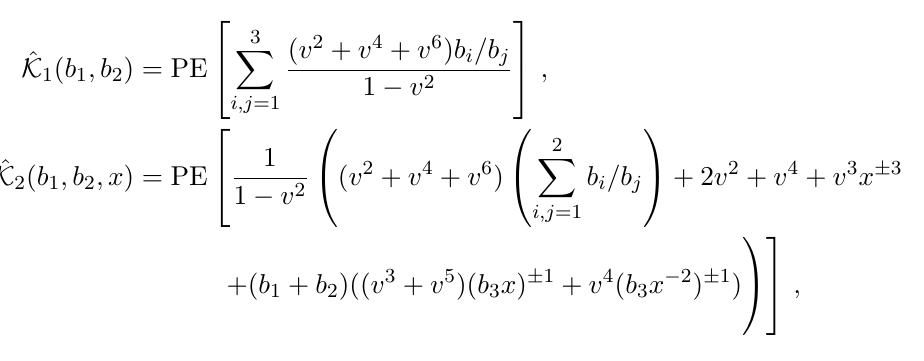
for the unre(cid:12)ned elliptic genus of three E 6 instanton strings.